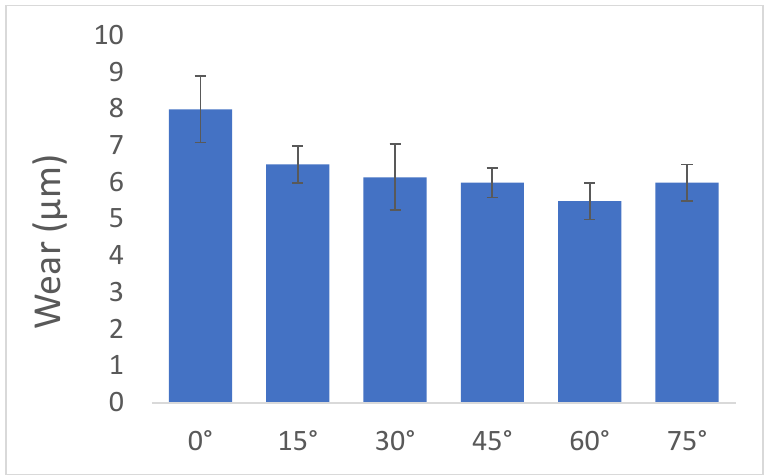
Figure 3. Wear scar depth for the following conditions: test duration 10 h, frequency 4 Hz, stroke 10 mm, maximum contact pressure 85 MPa, after [63].